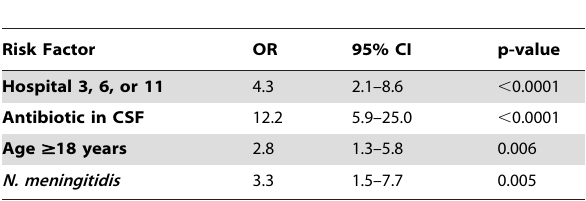
Table 4. Multivariable analysis of risk factors for being a RT- PCR positive, culture-negative case-patient, using culture positive patients as